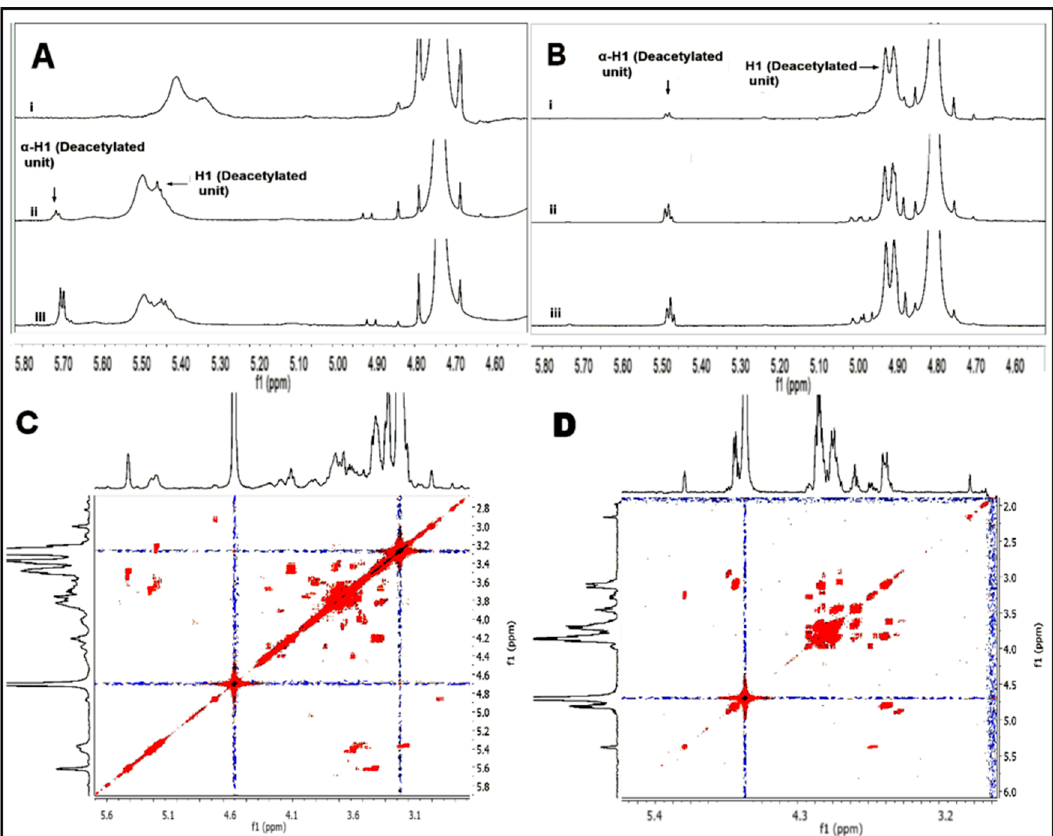
Figure 3. Figure showing the anomeric protons of TMC ( A ) and chitosan ( B ) in the 1 H-NMR spectrum obtained after different stages of hydrolysis (1 h, 4 h, and 48 h) using 12 M HCl. COSY-NMR spectra for TMC oligomer ( C ) and chitosan oligomer ( D ) obtained after 48 h of hydrolysis.